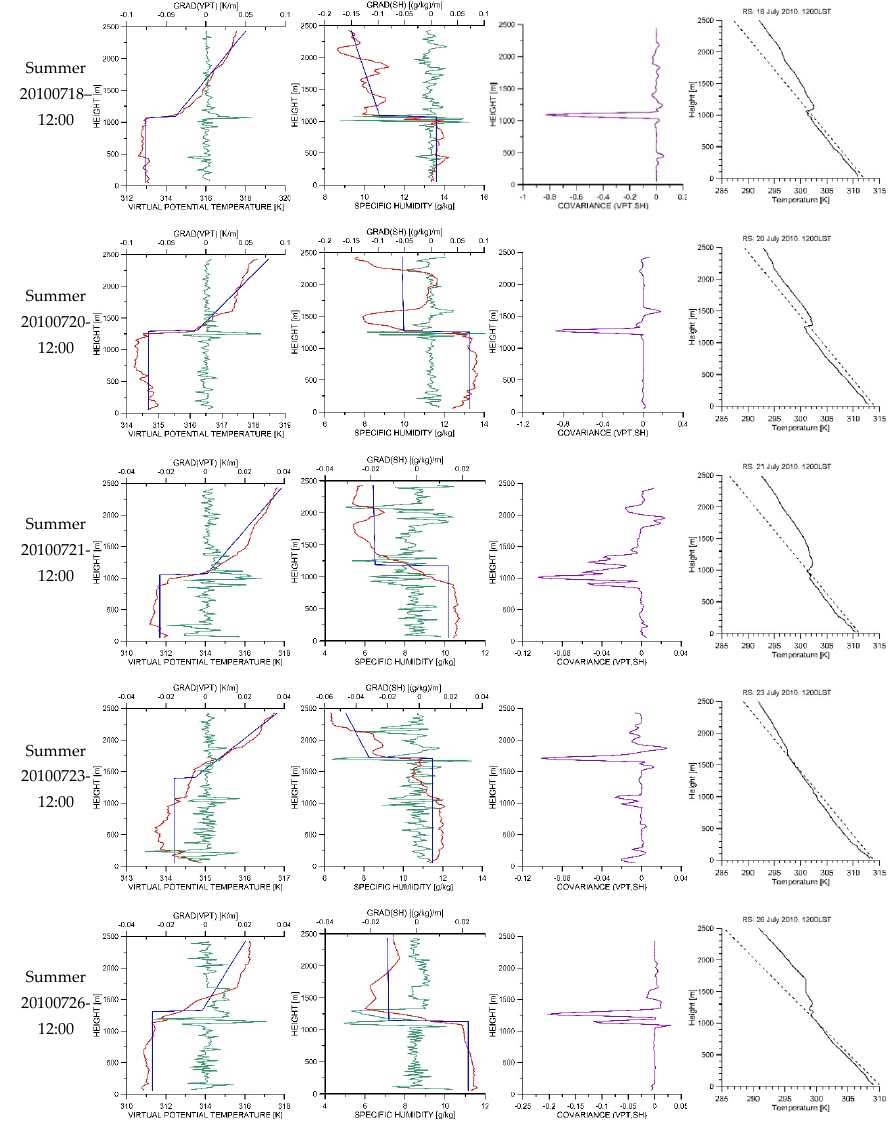
Figure 7. Application of the estimation methods to the VPT, SH, and T profiles of the 12:00 LST of the days 18, 20, 21, 23, and 26 of July 2010. First column: LSVA/VPT and GM/VPT. Second column: LSVA/SH and GM/SH. Third column: CM. Fourth column: PM.